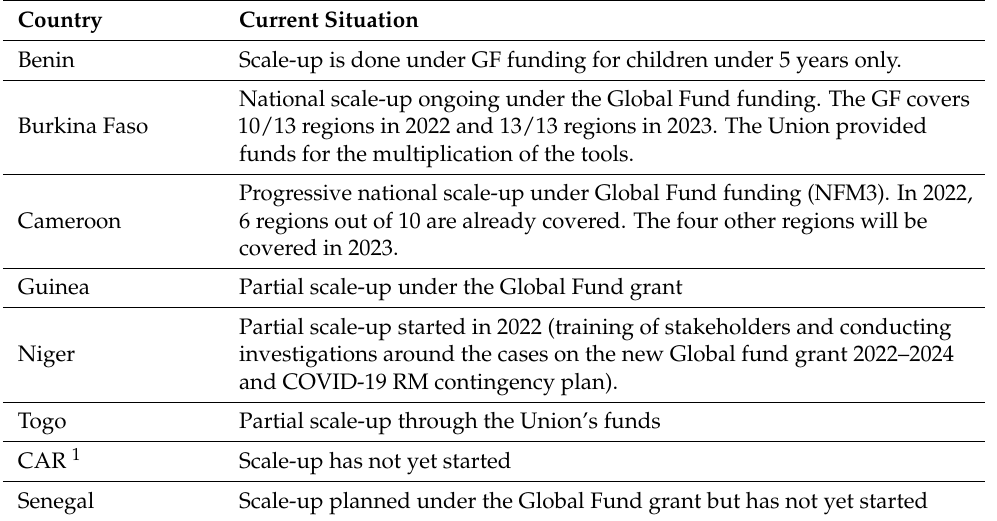
Table 6. Scale-up of contact investigation at national level. Country Current Situation Benin Scale-up is done under GF funding for children under 5 years only. Burkina